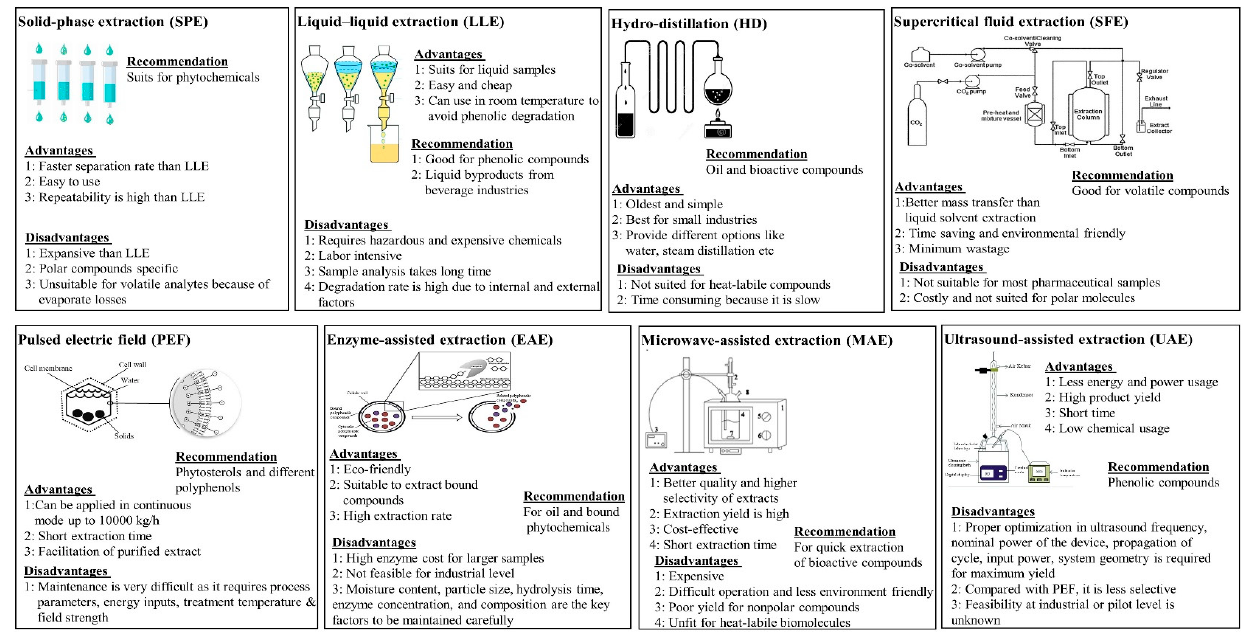
Figure 2. Some advantages, disadvantages, and recommendations of various extraction